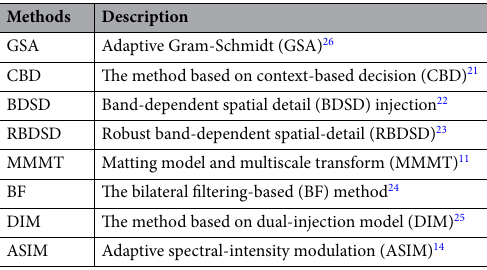
Table 2. Compared methods. Remark: All of the comparison methods were opened source codes offered by the corresponding authors.